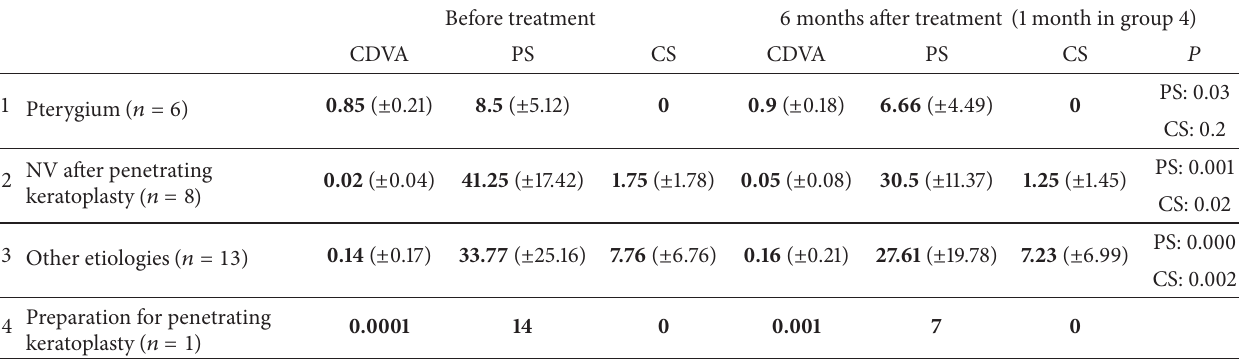
Table 2: Results of separate subgroups of group A before and 6 months after initiation of treatment; mean number of affected peripheral (PS) and central segments (CS) of neovascularization; corrected distance visual acuity (CDVA).